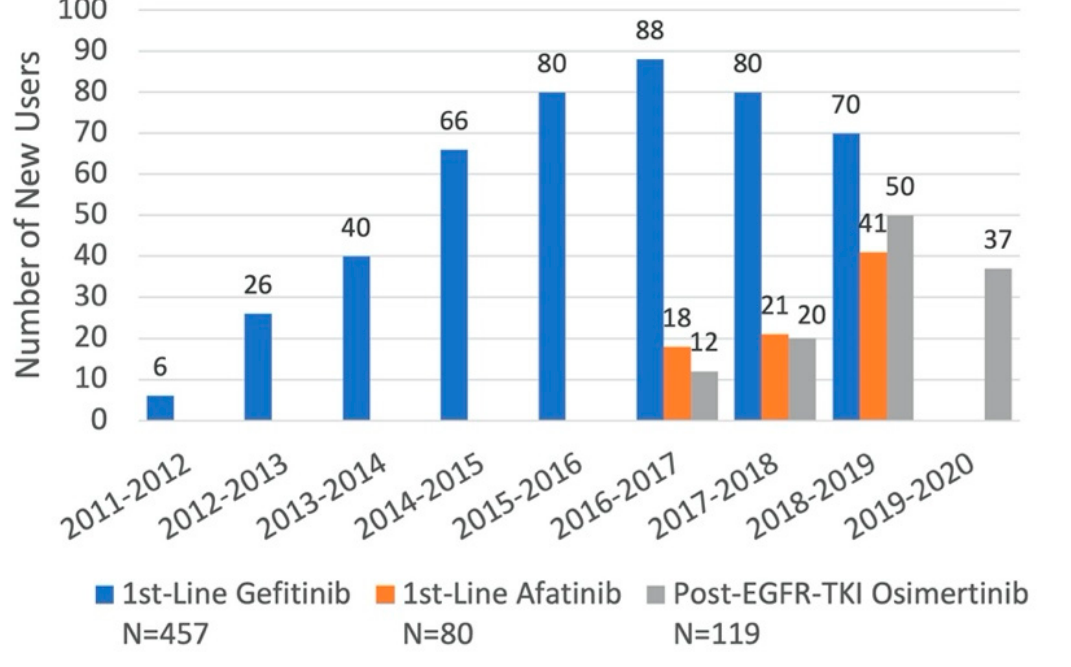
Figure 2. Distribution of New Users of Each EGFR-TKI for Specific Indications, by Fiscal Year.